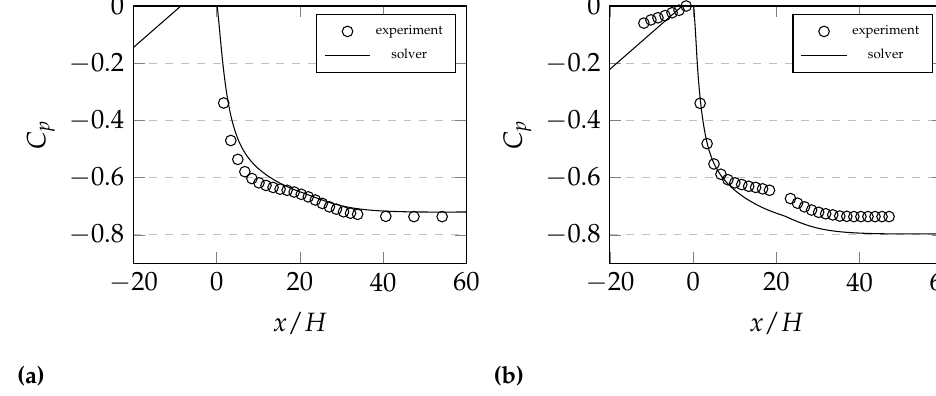
Version April 28, 2022 submitted to Appl. Sci. Figure 18. C p for the (a) top wall and the (b) bottom wall of the diffuser Figure 18. C p for the ( a ) top wall and the ( b ) bottom wall of the diffuser. Figure 18. C p for the (a) top wall and the (b) bottom wall of the diffuser